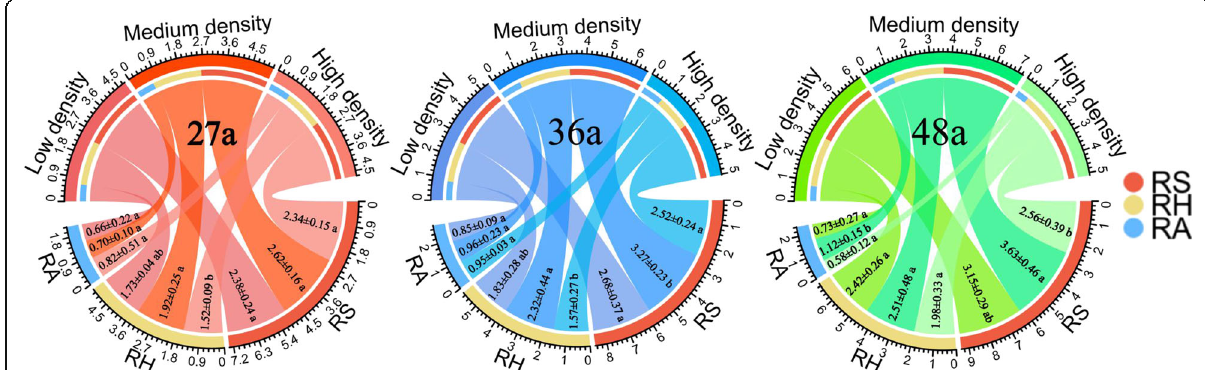
Fig. 2 Rs, Rh, and Ra for differently aged stands and stand density levels. Values are the mean ± standard deviation (SD). Different lowercase letters (a, b, and c) indicate significant differences ( P < 0.05) between different stand density levels. Rs, soil respiration; Rh, heterotrophic respiration; Ra, autotrophic respiration. 27a, 27-year-old stand; 36a, 36-year-old stand; 48a, 48-year-old stand